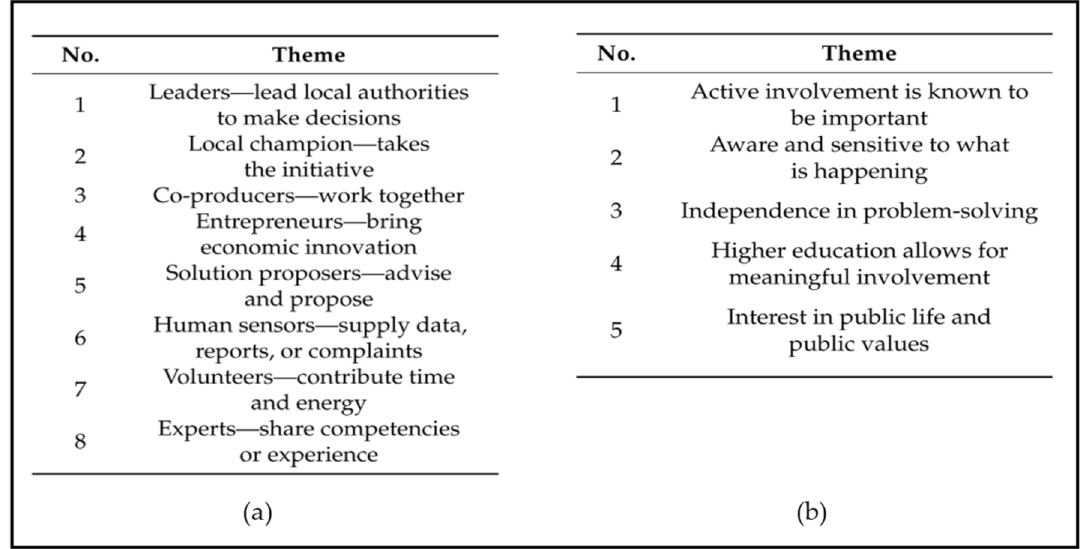
Figure 5. The characteristics of responsible or contributing citizen. ( a ) The roles [41], ( b ) The characters